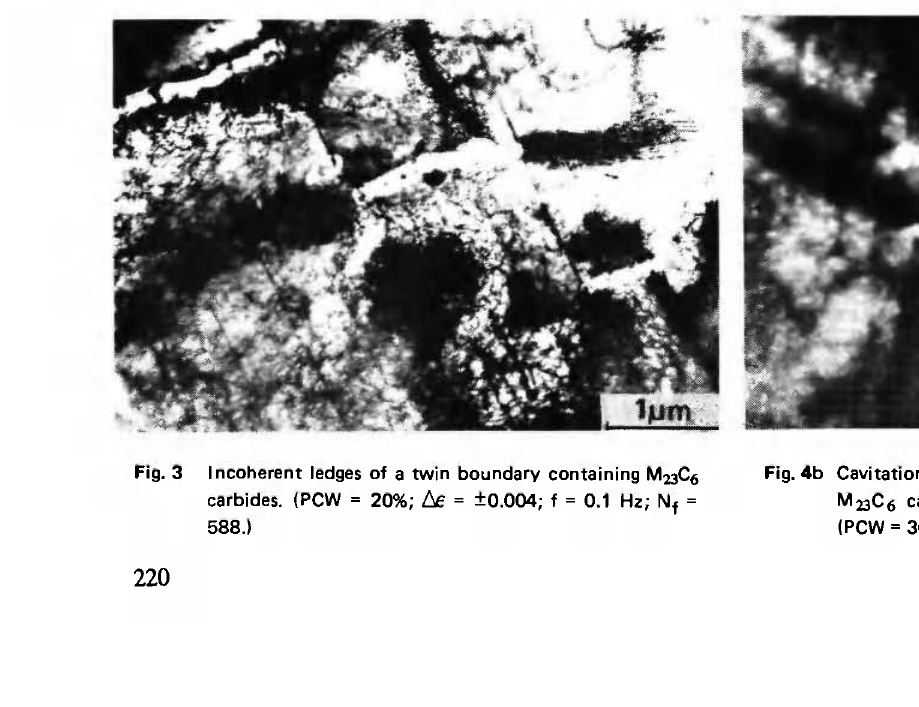
Fig. 4a Extensive precipitation of carbides along the deformation bands. (PCW = 20%; Δε = ± 0.006; f = 0.1 Hz; N f =